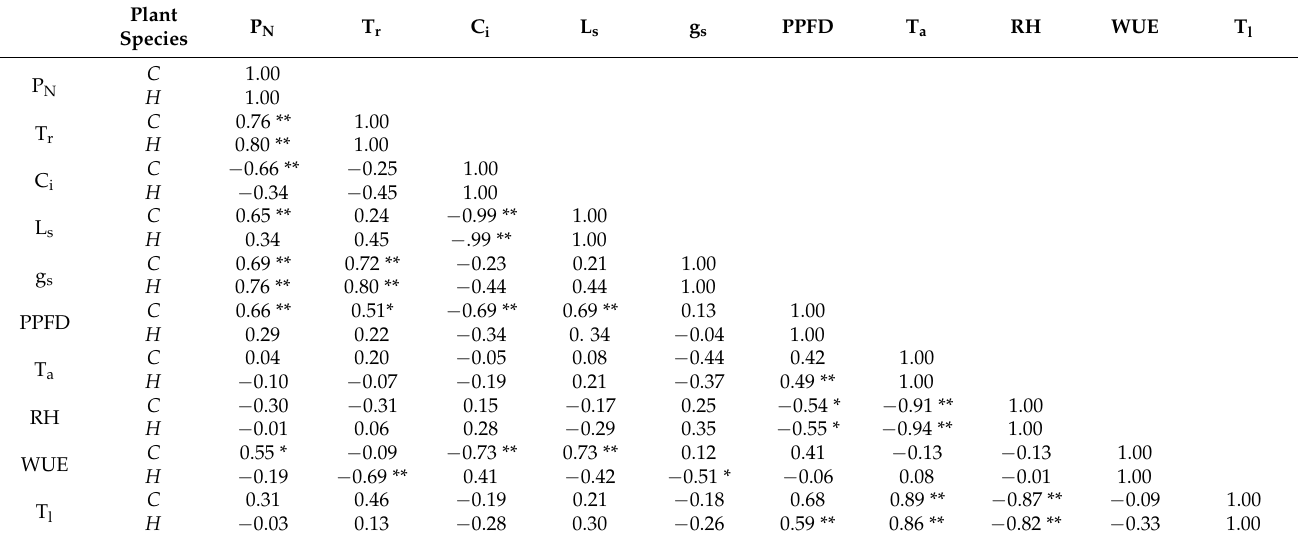
Table 2. The bivariate correlation test results comparing the environmental variables and plant physiology characteristics (P N —Net photosynthetic rate; T r —Transpiration rate; C i —Intercellular CO 2 concentration; L s —stomatal limitation; g s —Stomatal conductance; PPFD—Photosynthetic photo flux density; T a —Air temperature; RH—Relative humidity; WUE—Water use efficiency; T l —Leaf temperature; C — C. mongolicum ; H — H. ammodendron ) during July